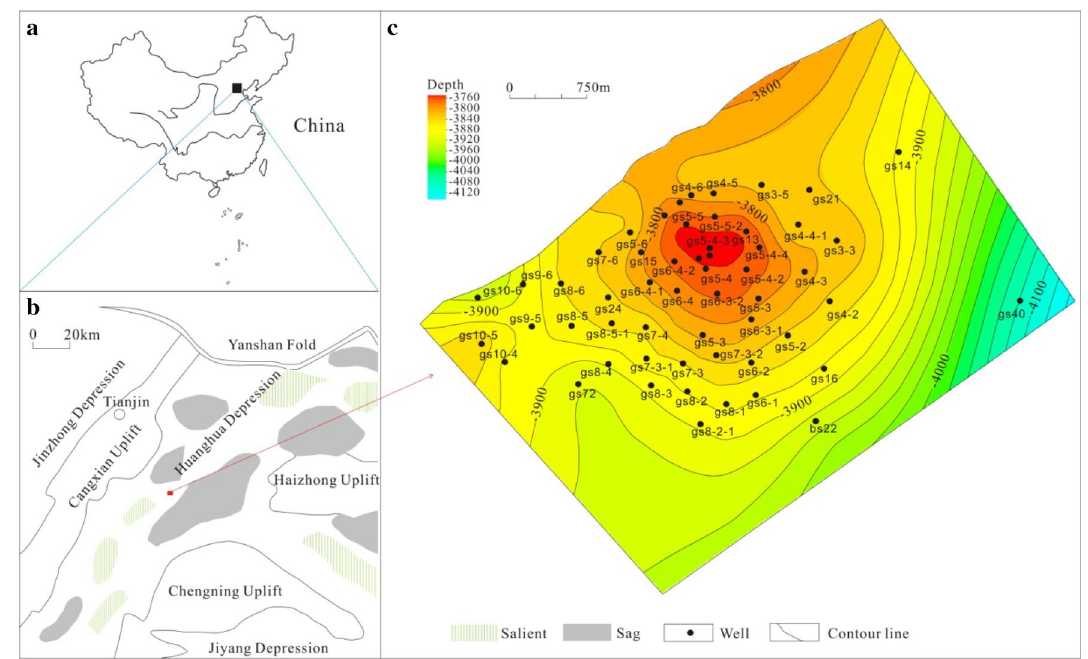
Fig. 1 Location map of Maxi Oilfield in Huanghua depression. a Location map of Huanghua Depression. b Tectonic location map of Huanghua Depression. c Tectonic map of Maxi